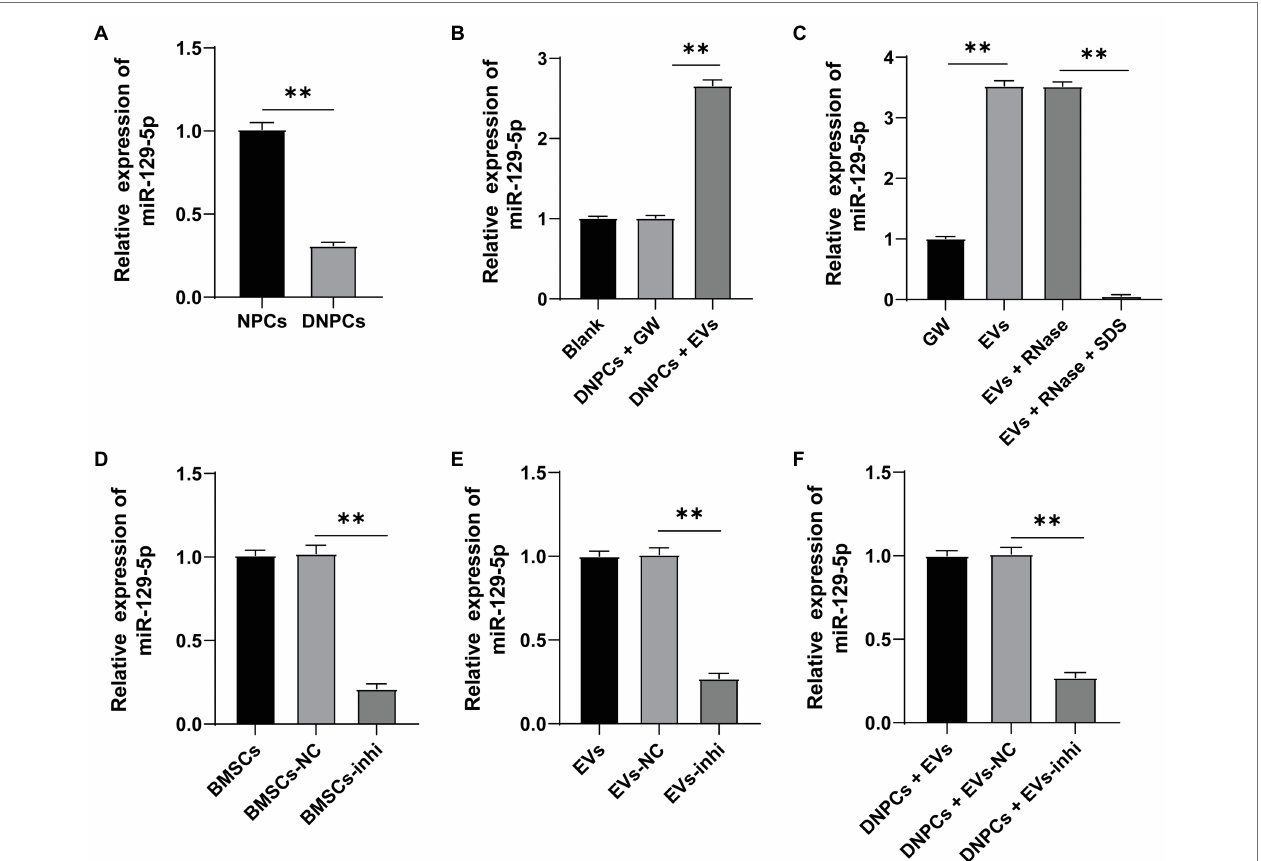
FIGURE 3 | Extracellular vesicles carried miR-129-5p into DNPCs. (A) miR-129-5p expression in NPCs and DNPCs detected by reverse transcription-quantitative polymerase chain reaction (RT-qPCR); (B) miR-129-5p expression in EVs-treated DNPCs detected by RT-qPCR; (C) miR-129-5p expression in EVs detected by RT-qPCR; hBMSCs were transfected with miR-129-5p inhibitor and EVs were isolated, and RT-qPCR was performed to detect (D) miR-129-5p expression in hBMSCs; (E) miR-129-5p expression in EVs; (F) miR-129-5p expression in DNPCs. Cell experiment was repeated three times. Data were presented as mean ± standard error. Data in panel (A) were analyzed using independent sample t test, while data in panels (B–F) were analyzed using one-way ANOVA, followed by Tukey’s multiple comparisons test. ** p <